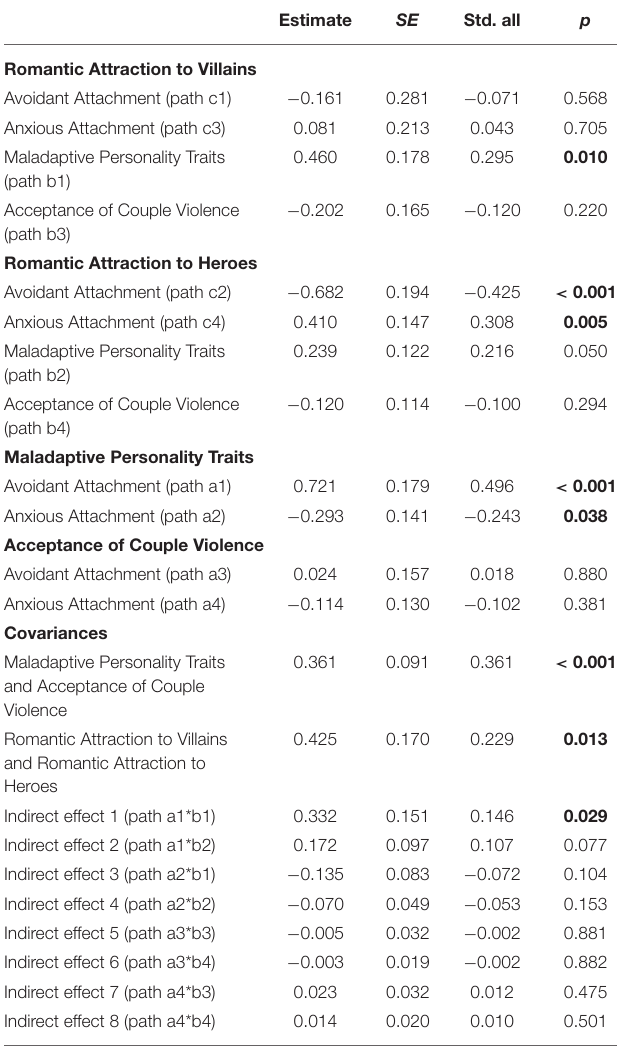
TABLE 8 | Unstandardized and standardized model results in Study 2 (Main Study). Estimate SE Std. all